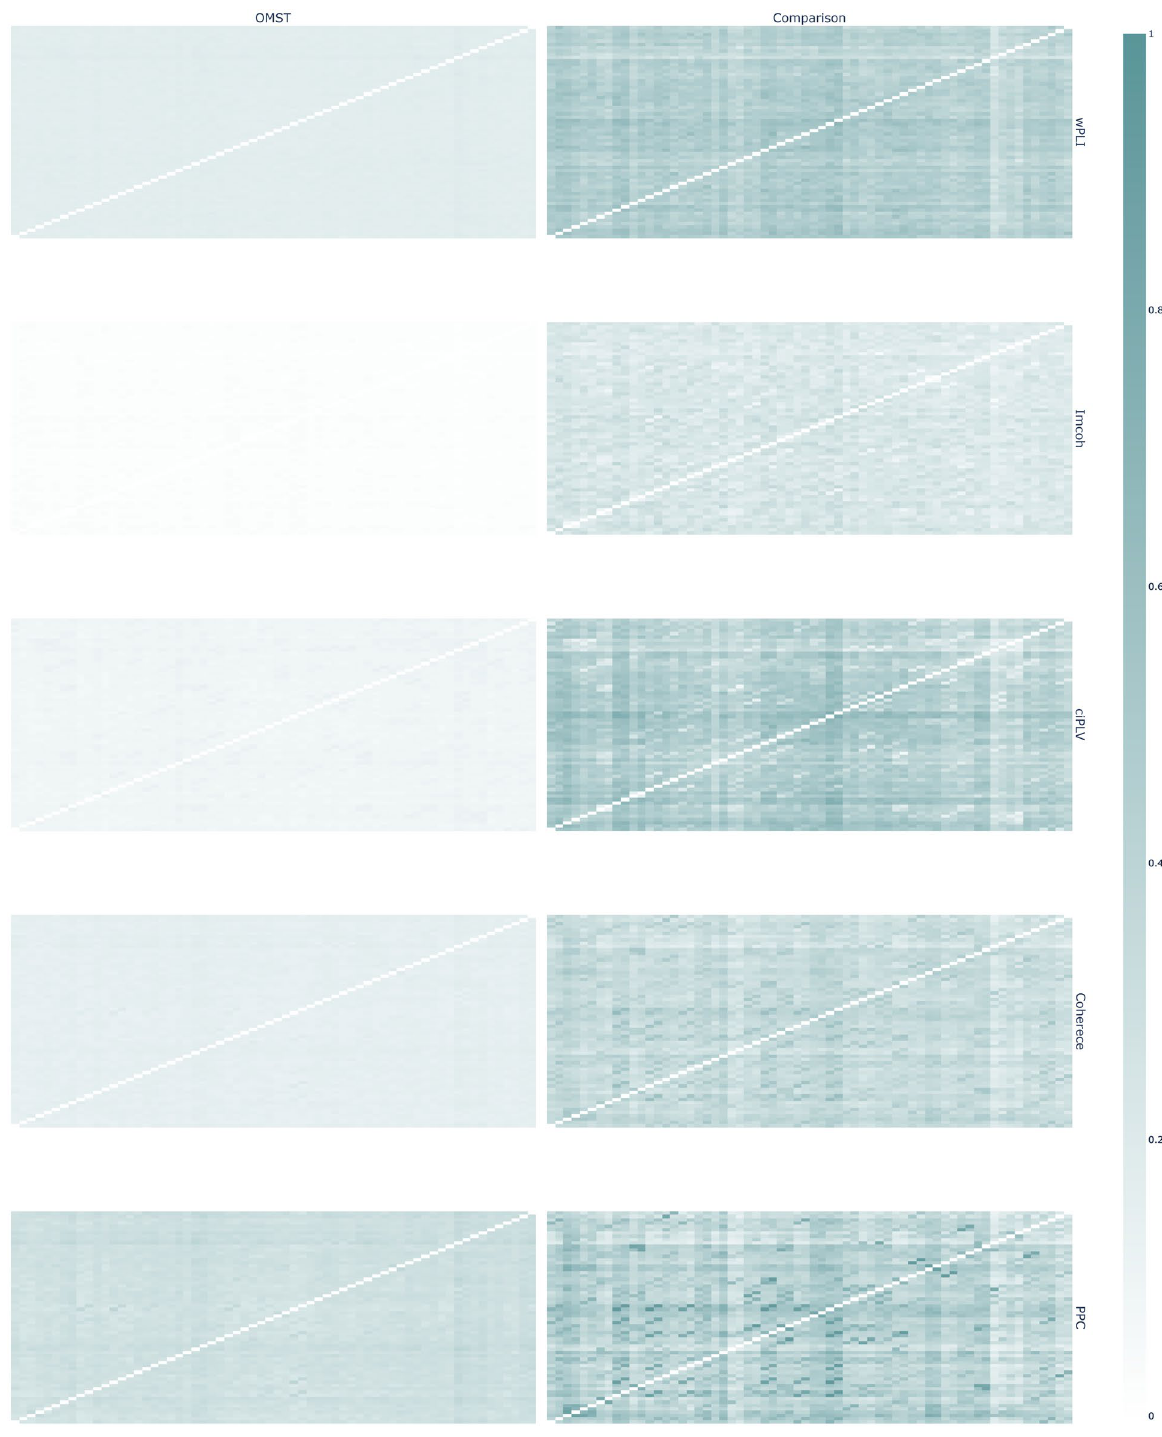
Figure 8. Graph structure for OMST-derived graphs and thresholded graphs of equal density in source space. The left column is OMST-derived networks, right—thresholded networks. The brightness of cells reflects the relative probability of edge existence. Brighter cells are more frequent in the individual networks in the sample. Synchronization measures by row: wPLI, Imcoh, ciPLV, coherence, PPC. Plotly 5.3.1 (https:// plotly. com/ python/) was used to create this